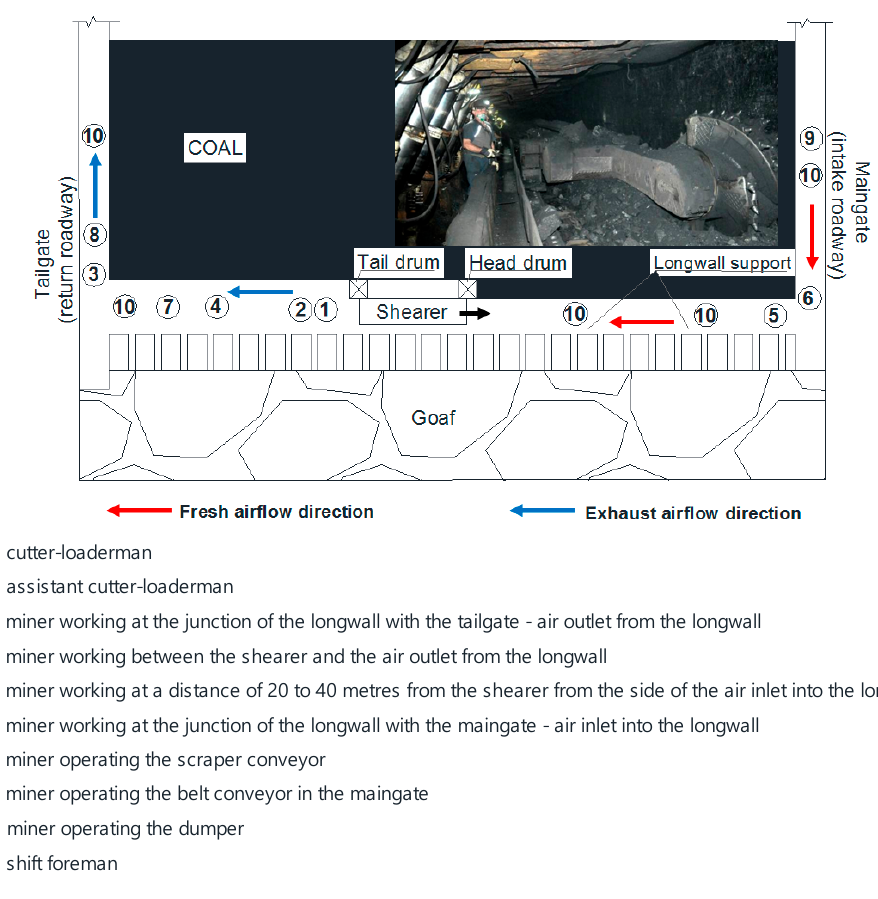
Figure 2. Typical U ventilation system in Poland with markers workplaces (modified from [35]).